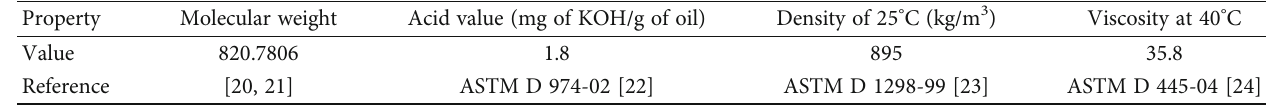
Table 2: Physicochemical properties of